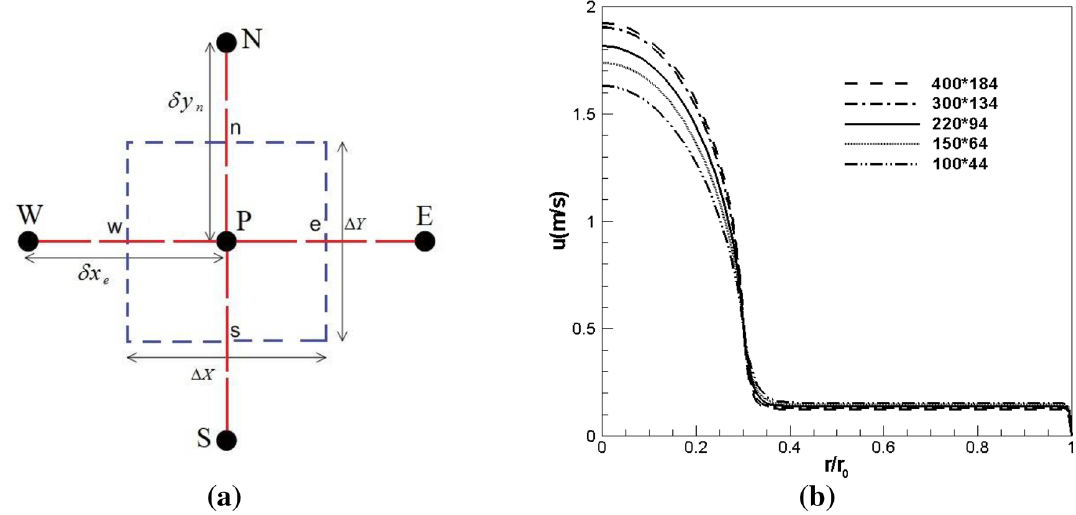
Fig. 2 a The control volume with the general node P, b variation of velocity along the pipe radius for the grid independency